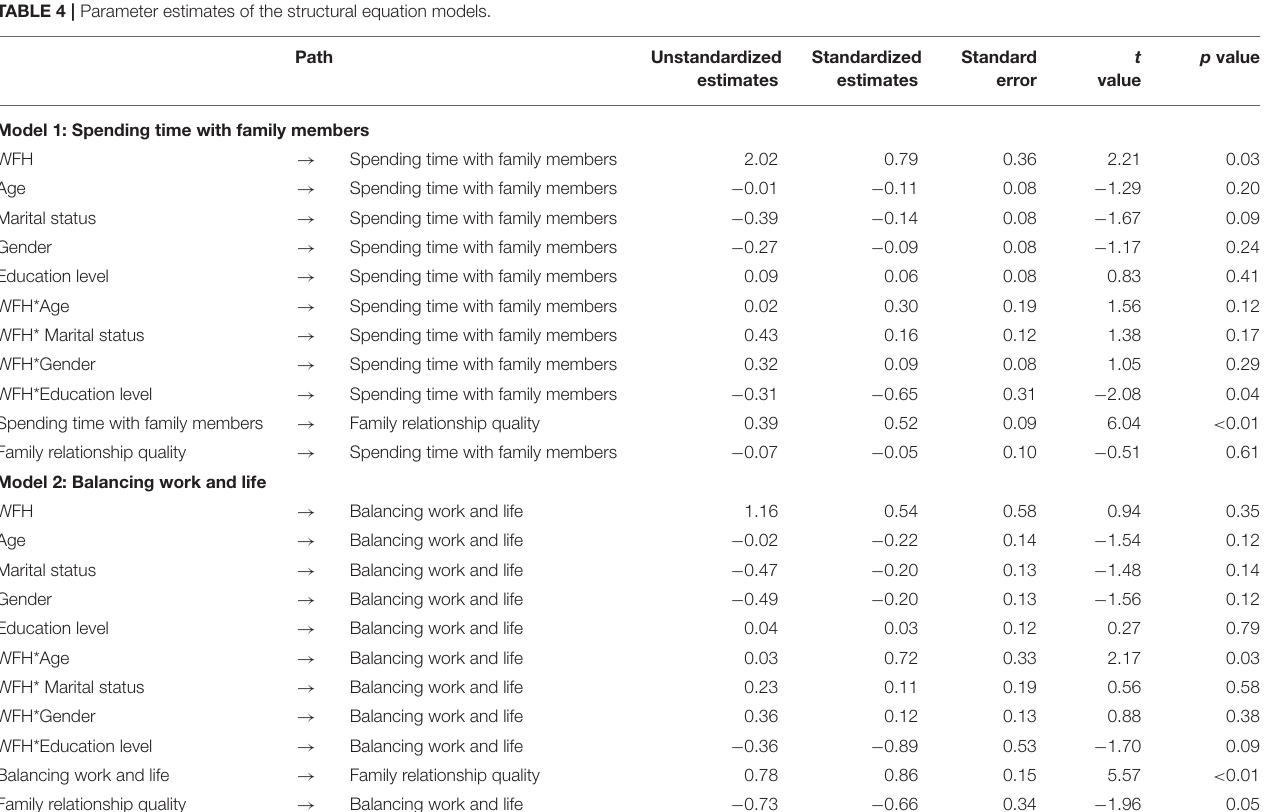
TABLE 4 | Parameter estimates of the structural equation